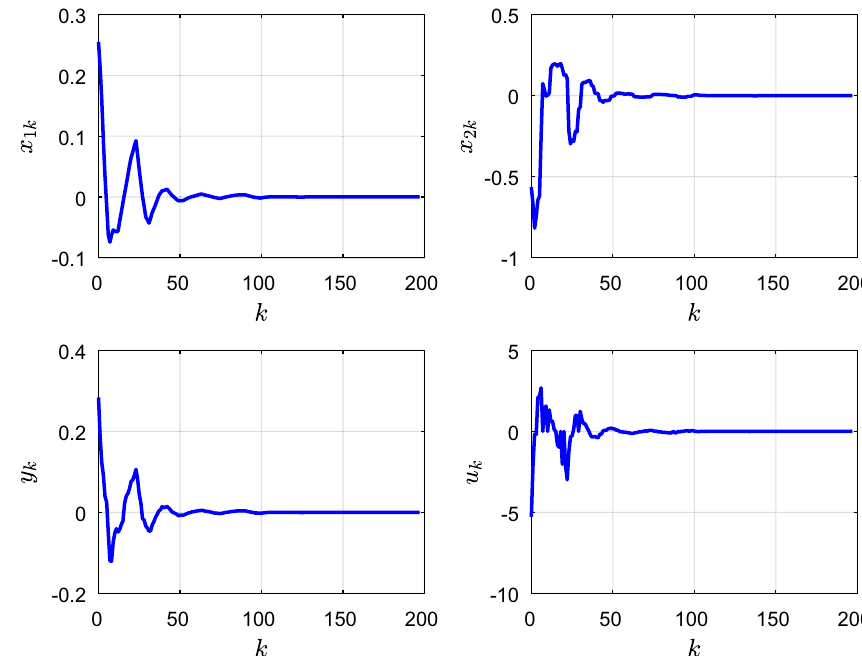
Fig. 2 System state, output and control input